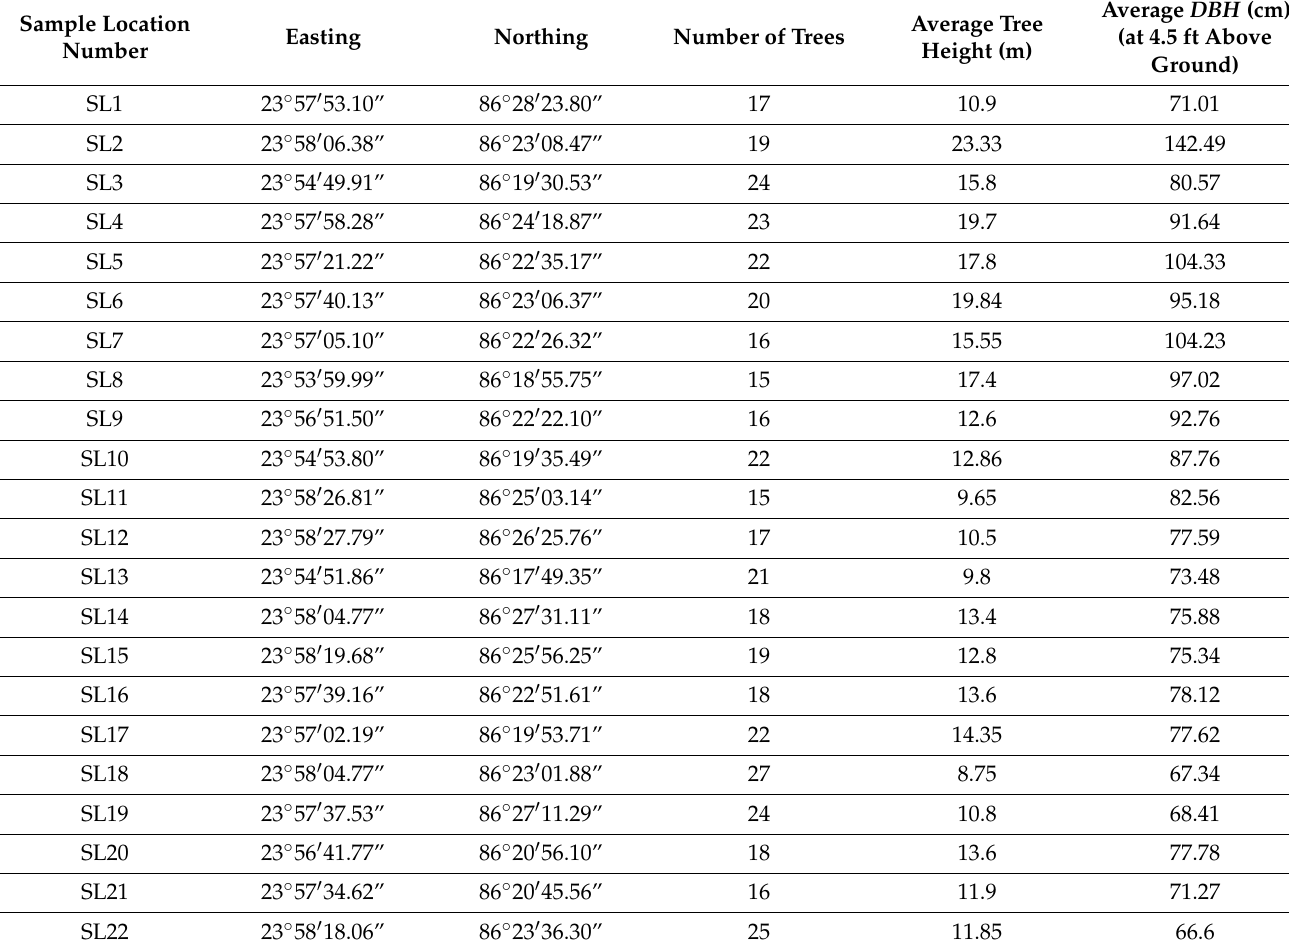
Table 2. Details of the ground data from the study